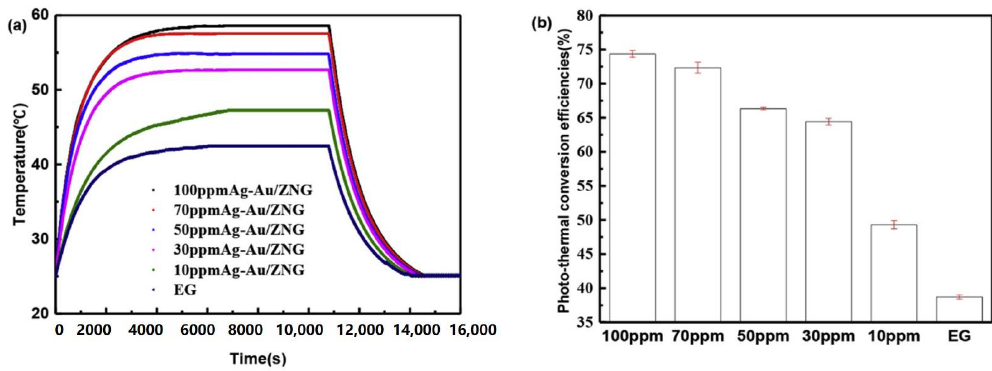
Figure 15. ( a ) Temperature variation and ( b ) photothermal energy conversion efficiency of Ag–Au/ Nitrogen doped graphitic polyhedrons (ZNG) nanofluid with various concentrations [30]; 2019, Elsevier.